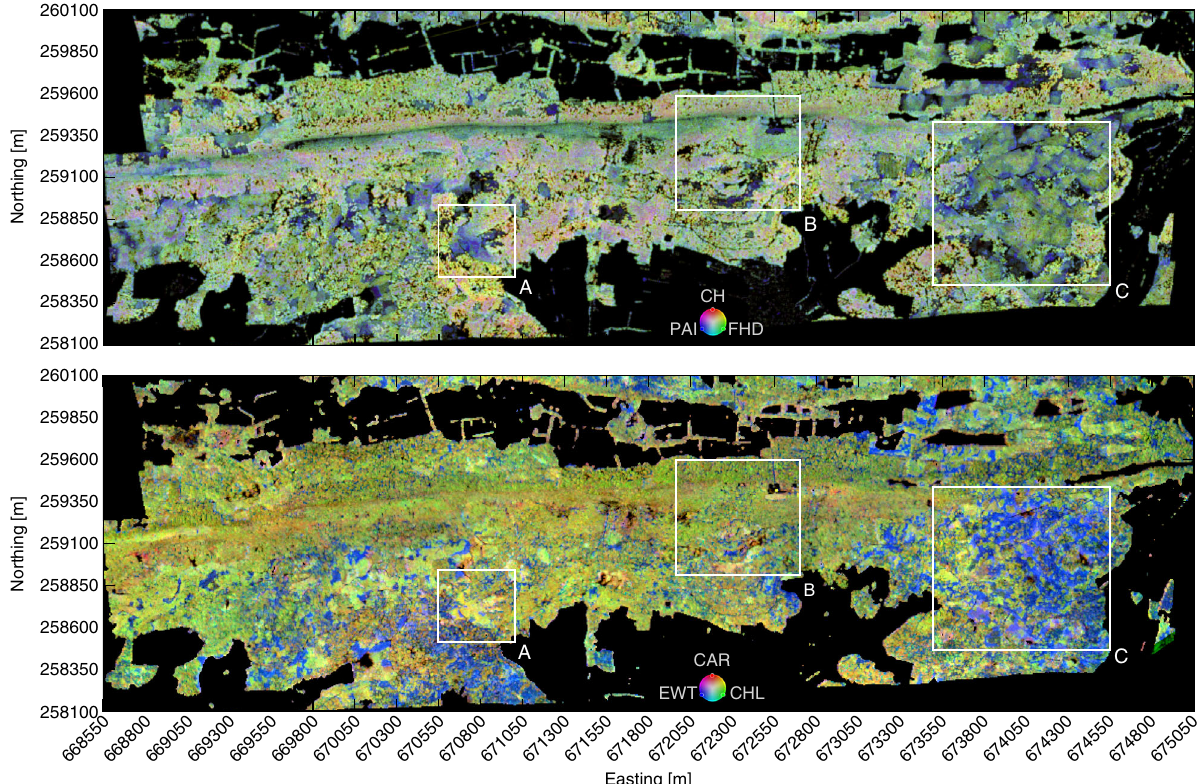
Fig. 3 Spatial composition of morphological and physiological forest traits. RGB colour composites of morphological traits (upper panel) plotted as abundance-scaled plant area index (PAI, blue), canopy height (CH, red) and foliage height diversity (FHD, green), and physiological traits (lower panel) plotted as abundance-scaled equivalent water thickness (EWT, blue), carotenoids (CAR, red) and chlorophyll (CHL,